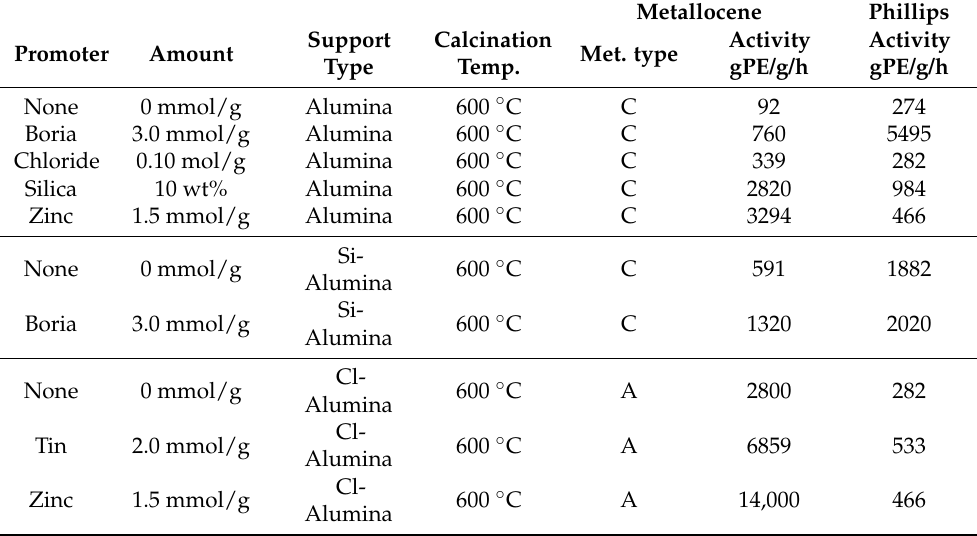
Table 4. The effect of other promoters that are known to increase acidity, on the polymerization activity of Phillips and metallocene